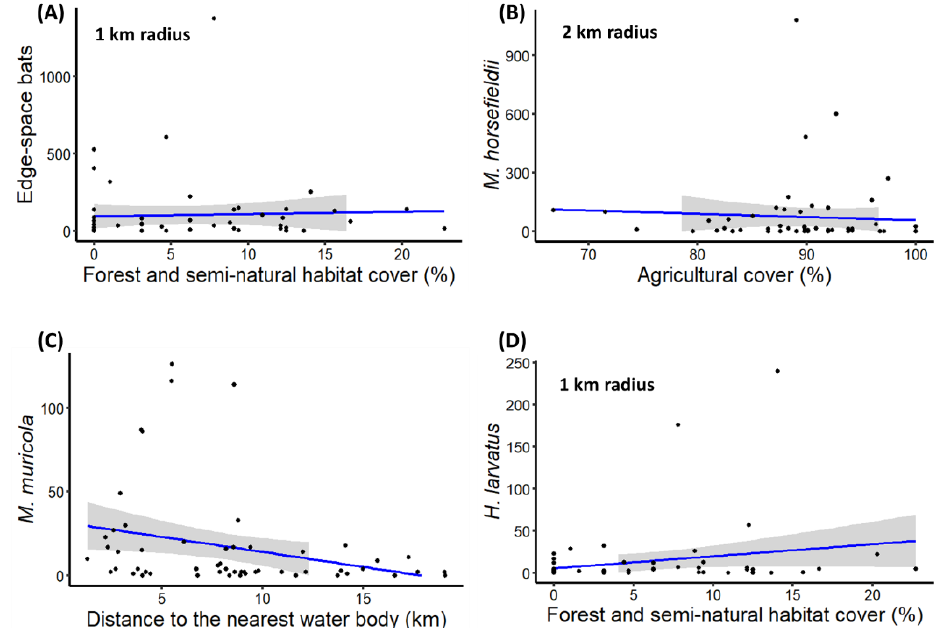
Figure 5. Effects of significant landscape factors on edge-space forging bats. ( A ) Percentage of forest and seminatural habitat cover within a 1 km radius had a significant positive effect on the activity of edge-space foraging bats, ( B ) proportion of agricultural cover within a 2 km radius had a significant negative effect on M. horsfieldii activity, ( C ) distance to the nearest water body had a significant negative effect on M. muricola activity, and ( D ) percentage of forest and seminatural habitat cover within a 1 km radius had a significant positive effect on the activity of H. larvatus . All regressions are plotted with 95% confidence intervals.